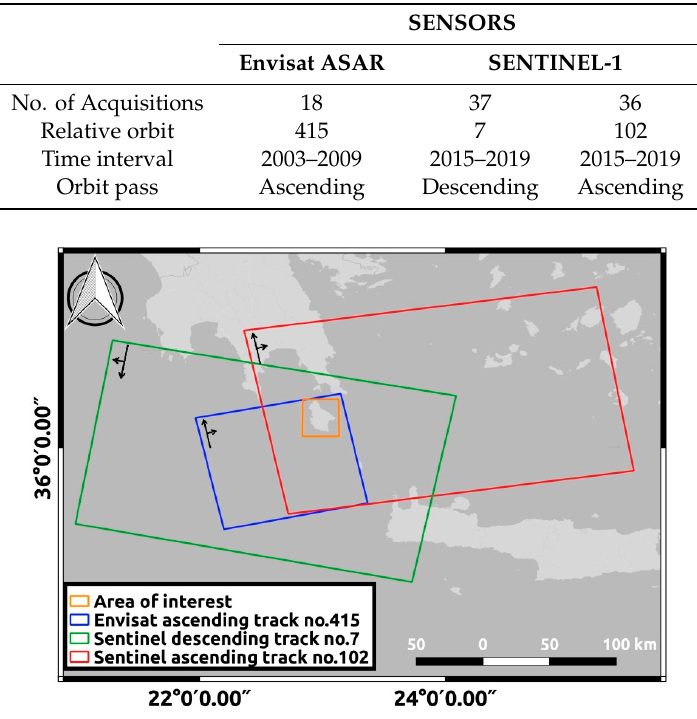
Figure 2. Map of the area of interest and the corresponding footprints of the satellite